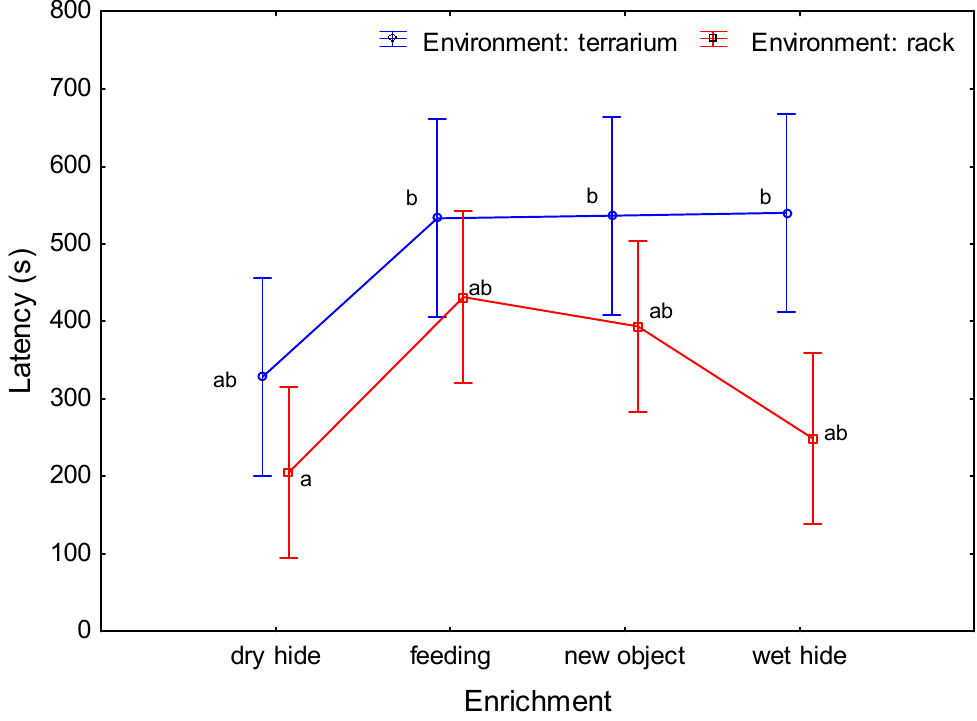
Figure 3. Medium latency (s) in approaching enrichment for studied environments (terrarium and rack) and enrichment items (vertical bars denote 0.95 confidence intervals; groups that do not have a common letter differ signi fi cantly).